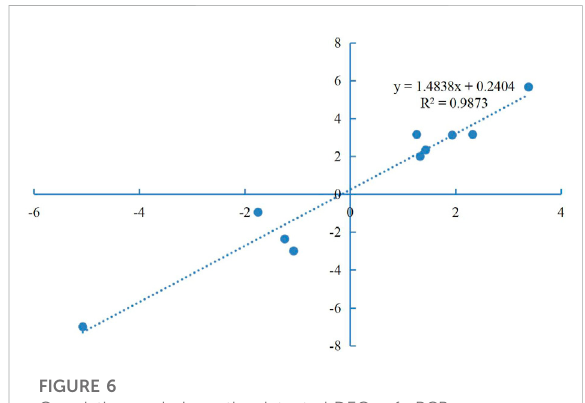
FIGURE 6 Correlation analysis on the detected DEGs of